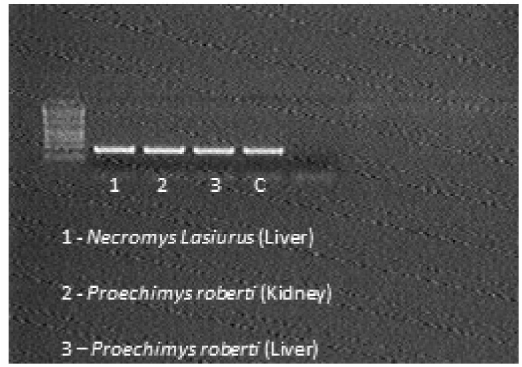
Figure 5. Proechimys roberti.